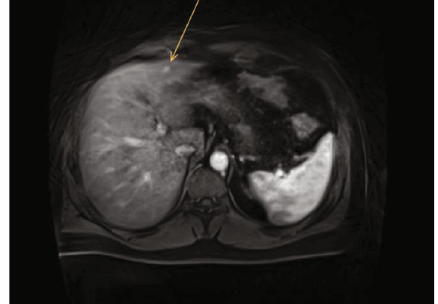
Figure 2: Liver MRI one month earlier demonstrated only one lesion in segment 3 and no lesion in segment